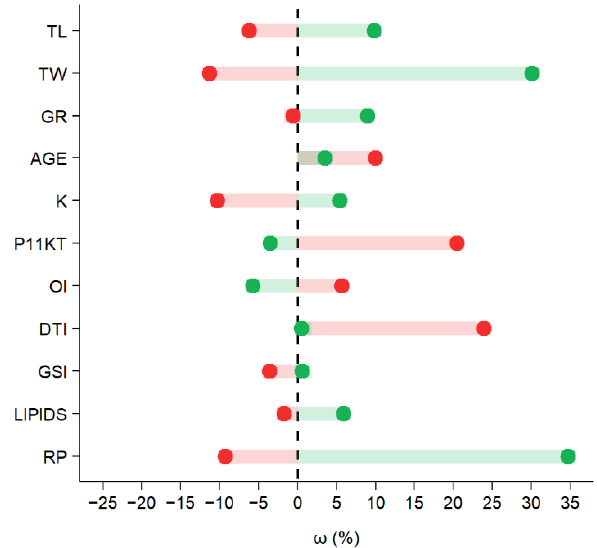
Figure 4. Average phenotypic reaction of female silver eel traits along a simulated gradient of contamination. The phenotypic reaction ( ω ) was computed as the proportional variation between the average of observed life history traits (centred and dashed line) and the average of predicted traits in the optimistic (low bioaccumulation) or pessimistic (high bioaccumulation) scenarios.